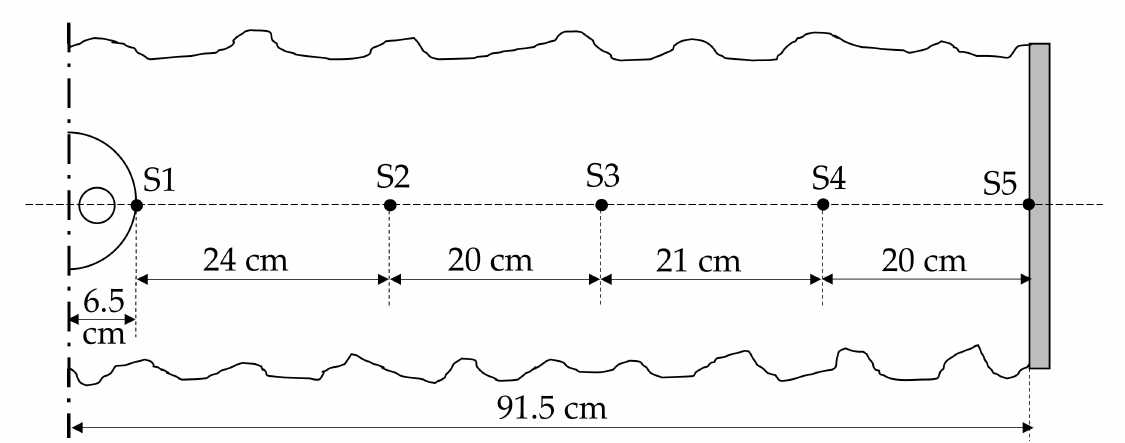
Figure 2. Illustration of a part of a cross section of the sandbox, with the radial positions of the temperature sensors placed in the